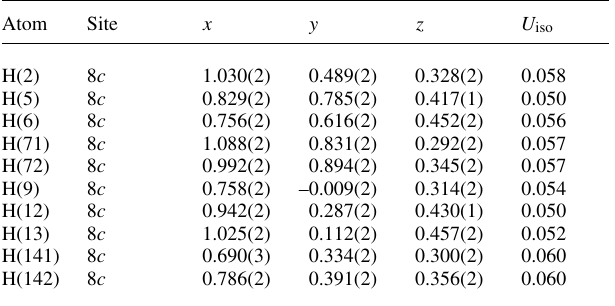
Table 2. Atomic coordinates and displacement parameters (in Å 2 ) .